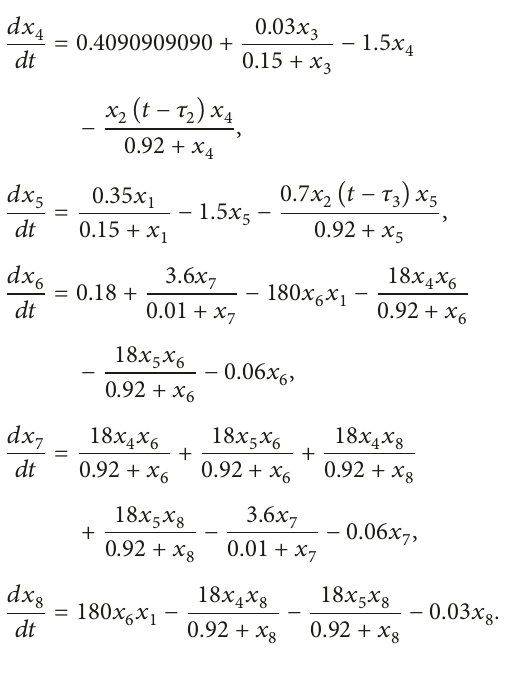
𝑥 = 1.2, 𝑥 = 1 2 = 0, 𝑥 = 0 , and 7 8